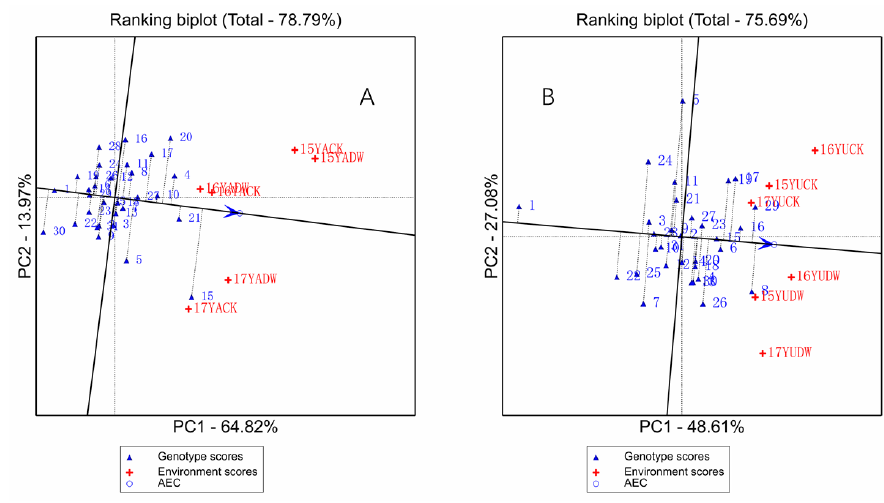
Figure 5. Mean vs. stability GGE biplots for Yangling ( A ) and Yulin ( B ).